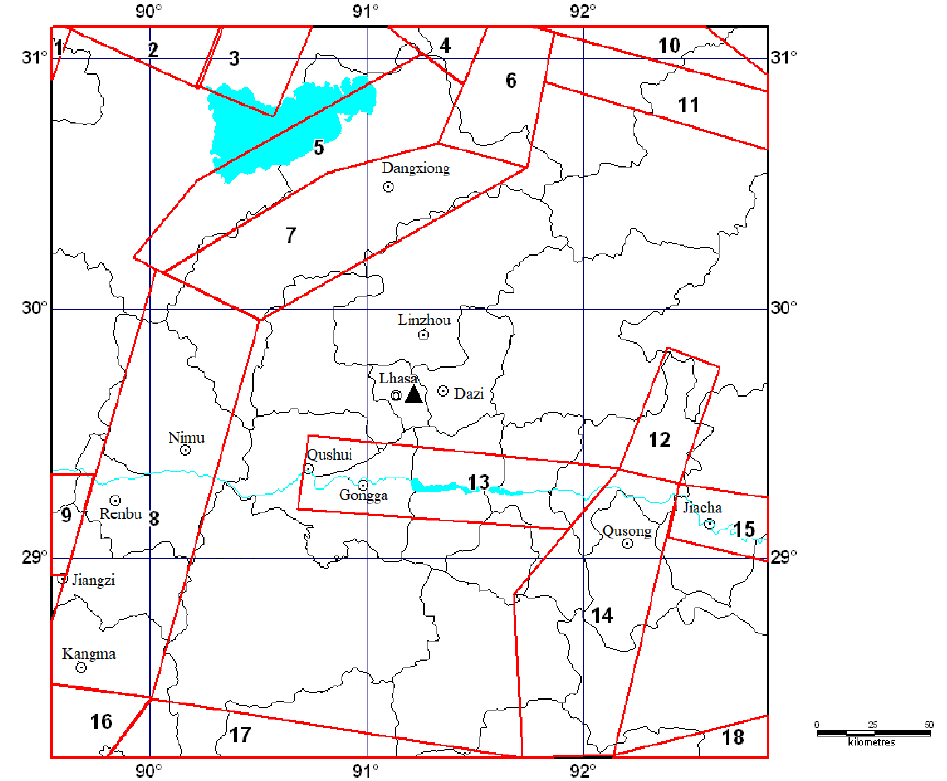
Figure 2. Division map of 18 potential seismogenic zones (red lines) according to this study. The numbers indicate the zone number. Black curves indicate the county boundaries.